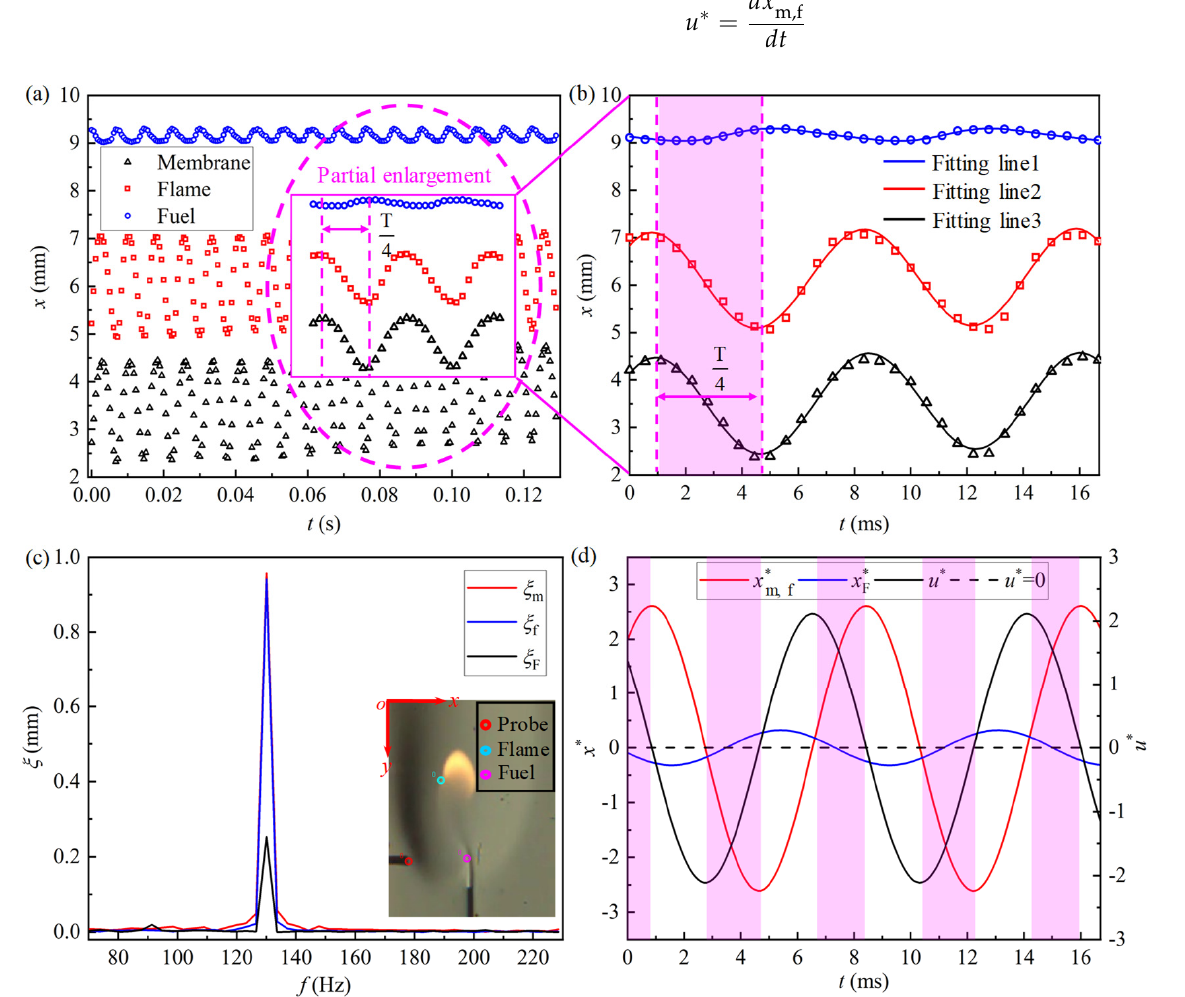
Figure 8. The oscillation characteristics of the membrane, flame, and unburned fuel were compared together (the acoustic frequency f = 130 Hz): ( a ) time dependence data; ( b ) fitting lines; ( c ) the oscillation frequencies and amplitudes; ( d ) the flame and unburned fuel moved in opposite directions during the deceleration period of macro.